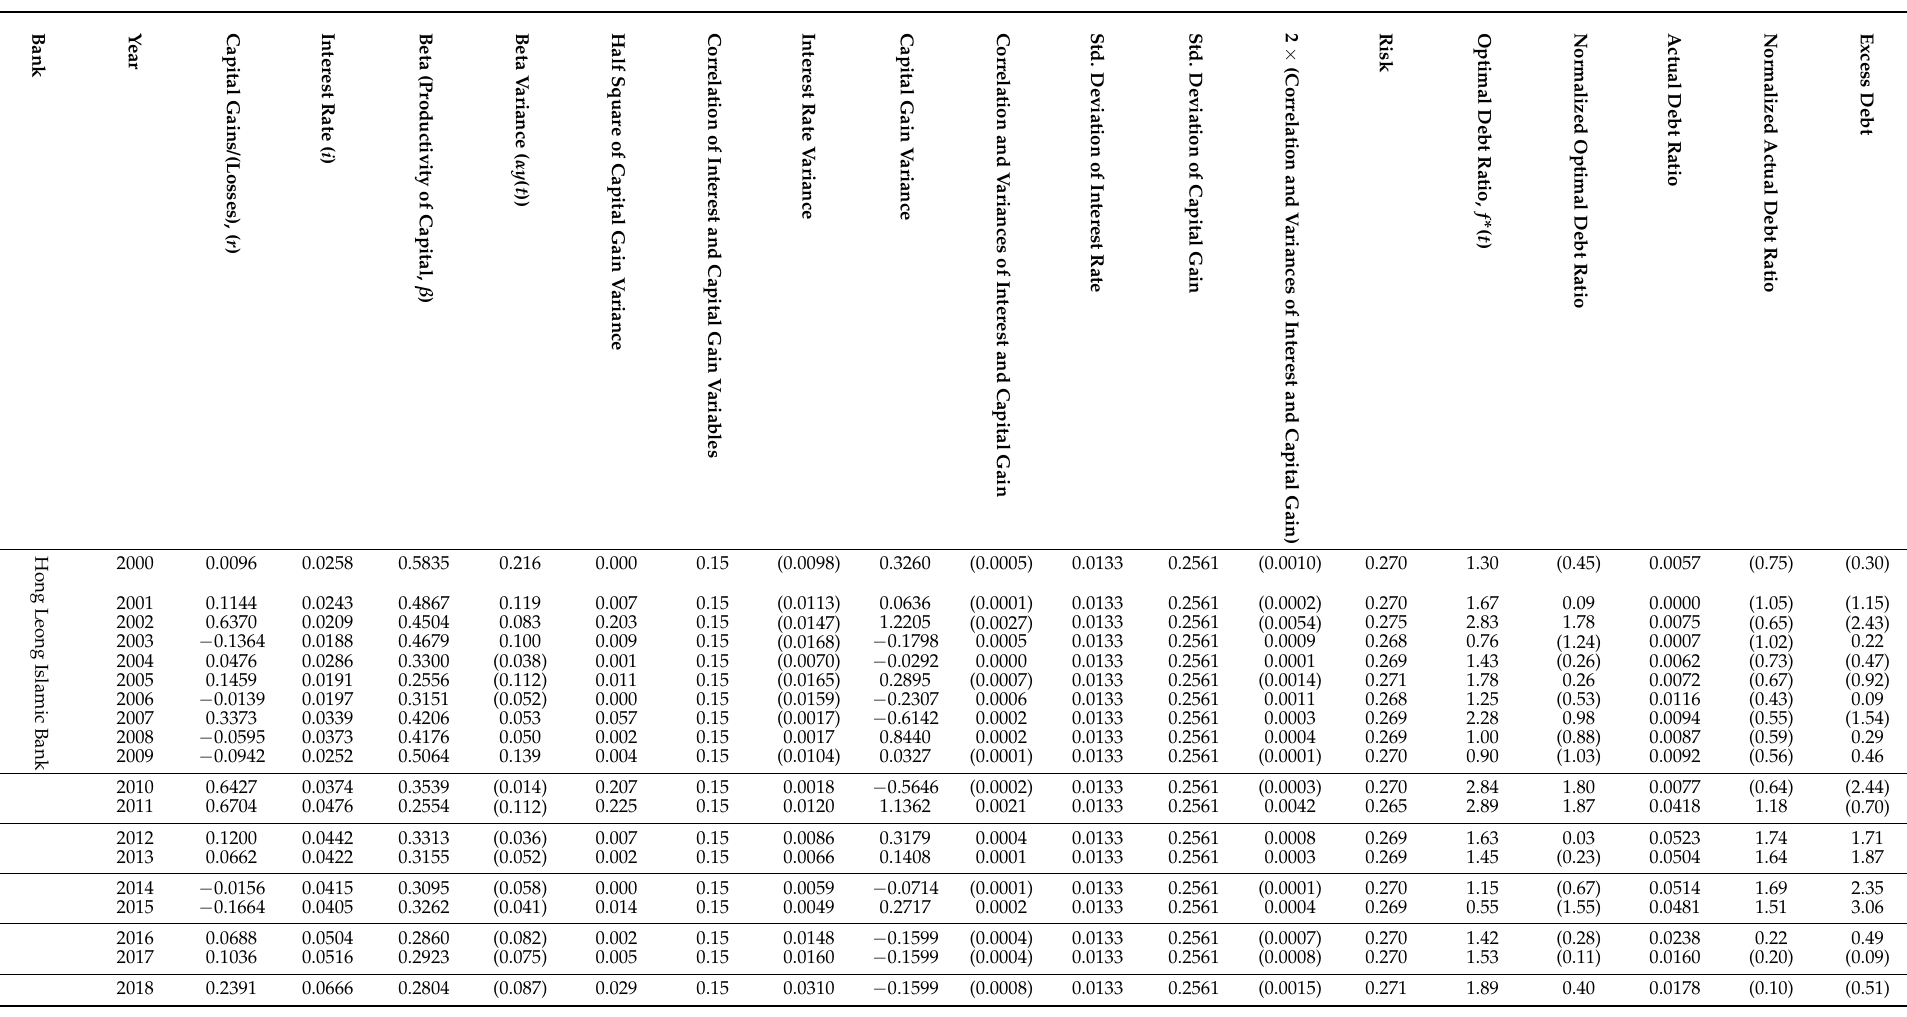
Table A4. Calculations of Optimal and Excess Debt: Hong Leong Islamic